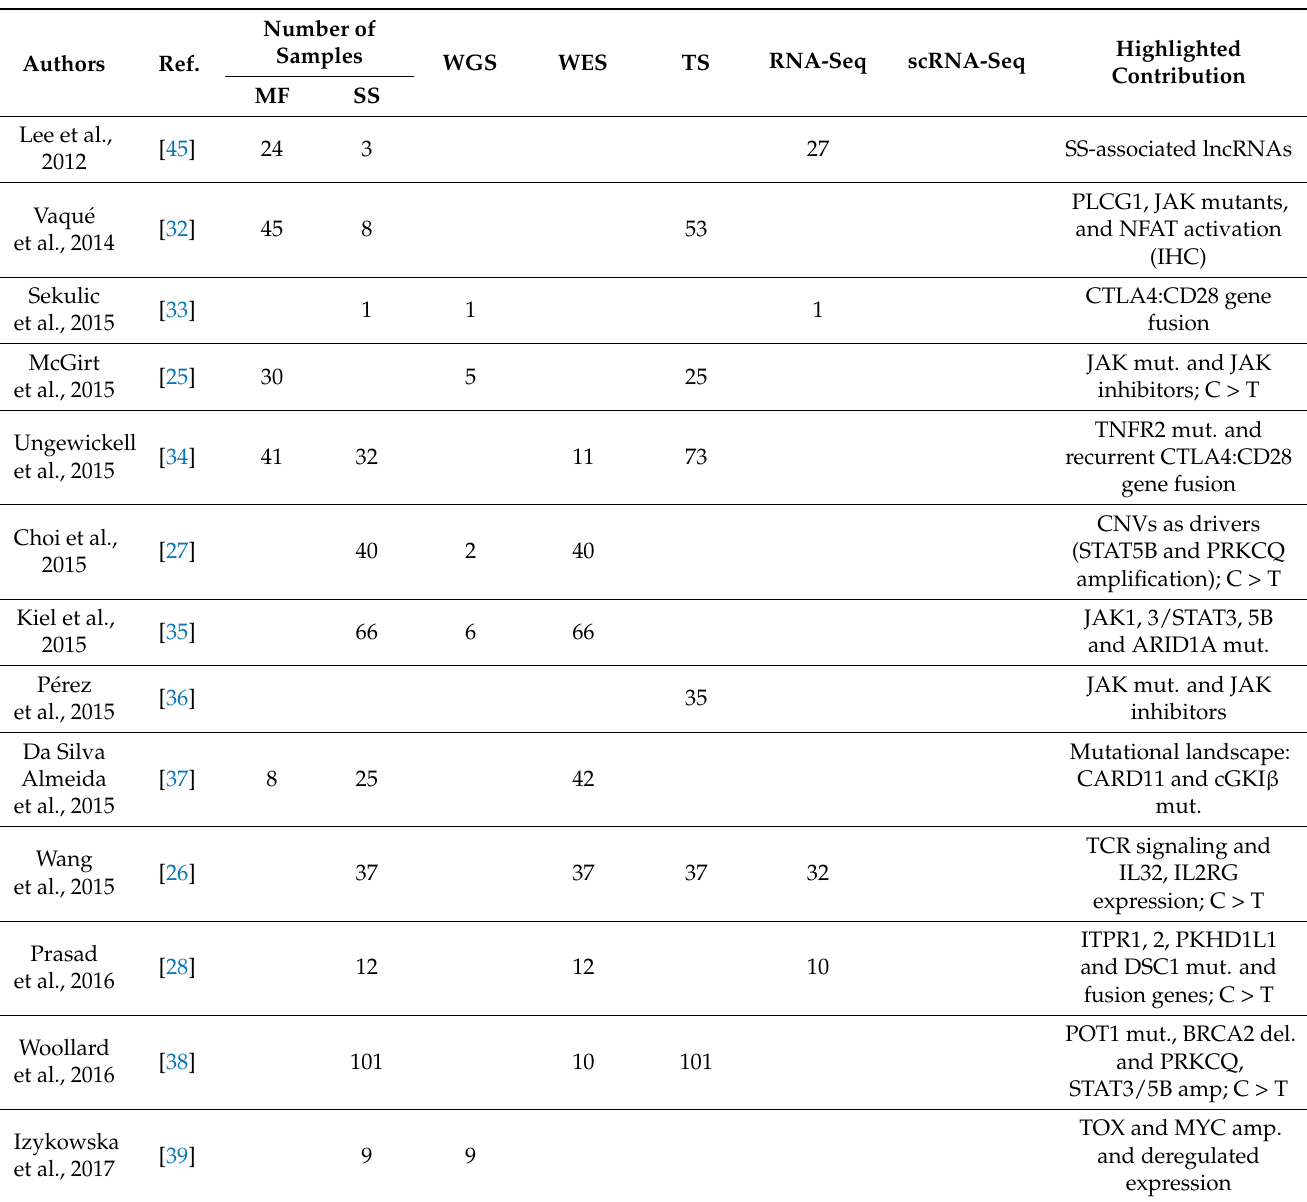
Table 2. Next-generation sequencing studies in